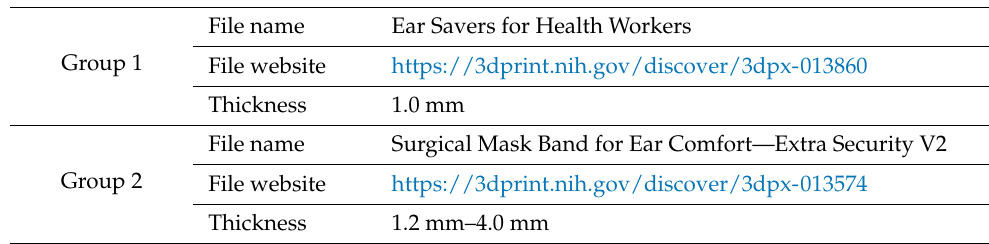
Table 1. Groups of